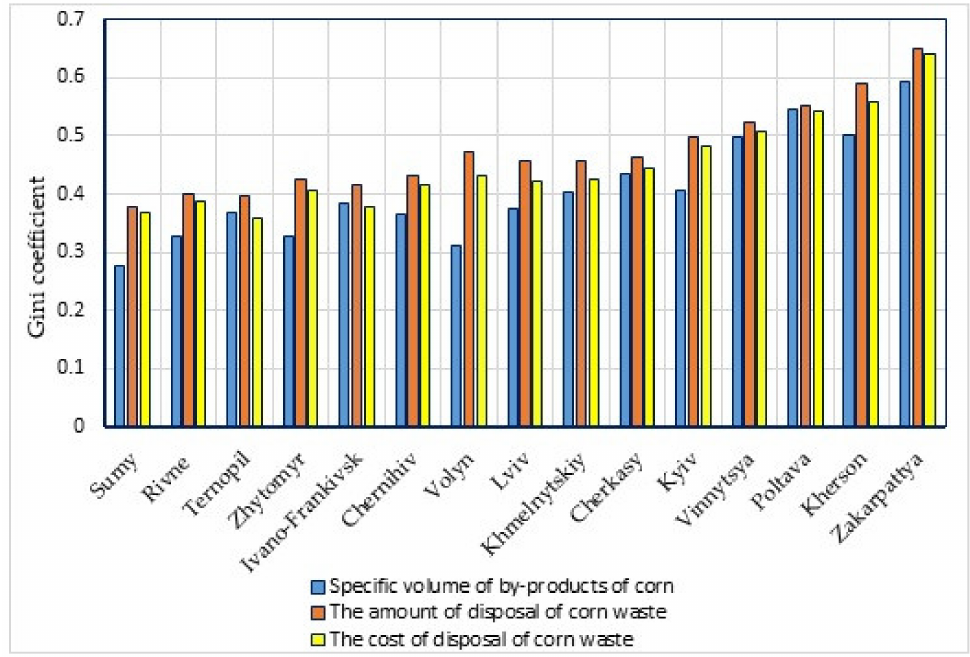
Figure 8. Trends in the Gini index by individual indicators for certain regions of